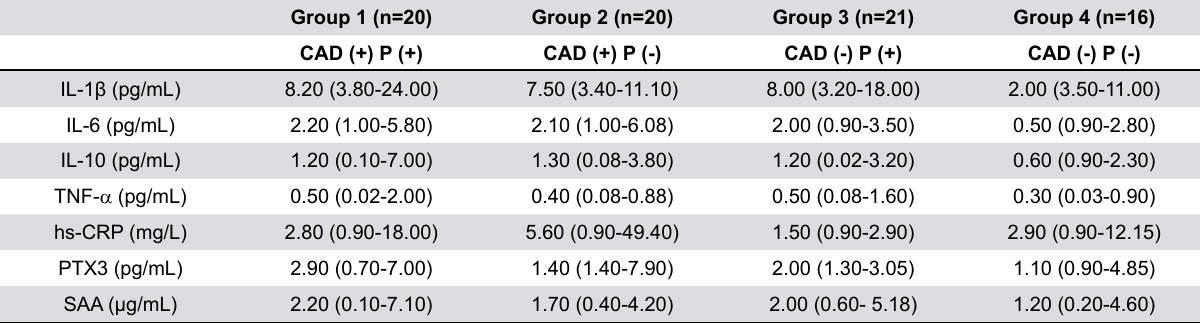
Table 3- Serum cytokine and acute phase reactants (APR) levels [median